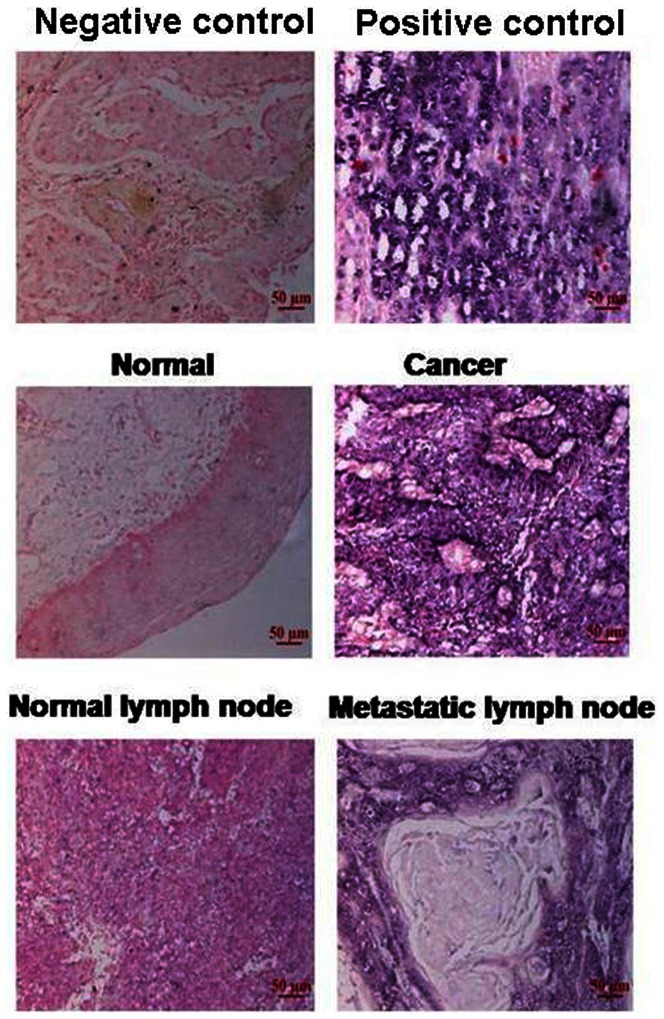
Increased HOTAIR expression was detected in ESCC tissues and metastatic lymph nodes.Representative images of in situ hybridization for HOTAIR in non-ESCC tissue, ESCC tissue, a normal lymph node and a metastatic lymph node.